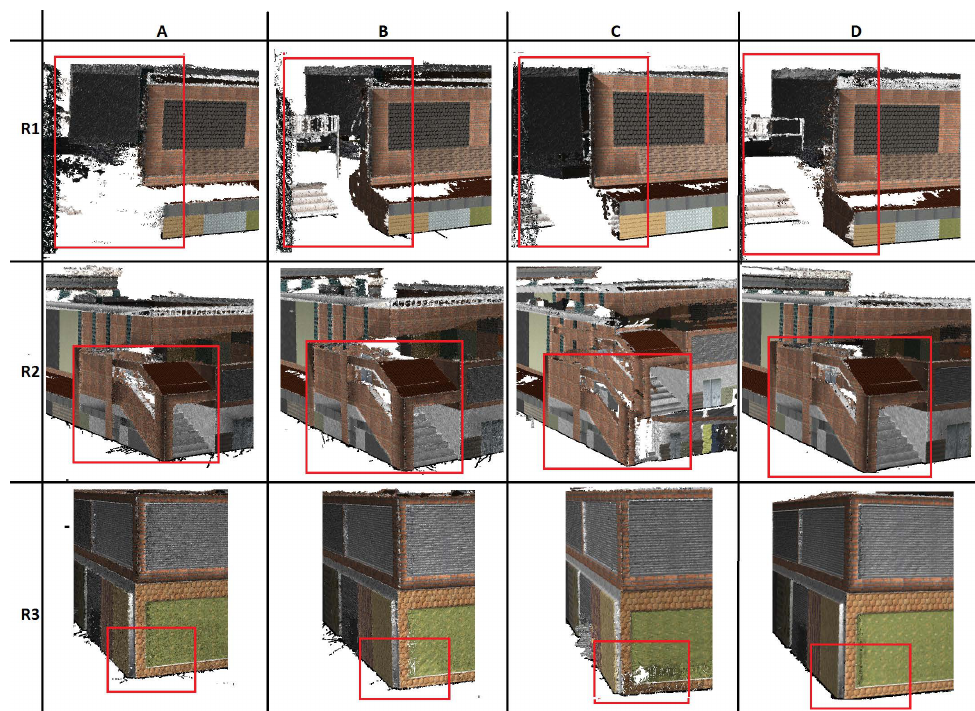
Figure 14. The details of the results in the three selected areas (R1, R2, R3) for all of the image acquisition approaches: centre pointing ( A ), façade pointing ( B ), hybrid ( C ) and combined ( D ). The hybrid strategy ( C ) showed incomplete